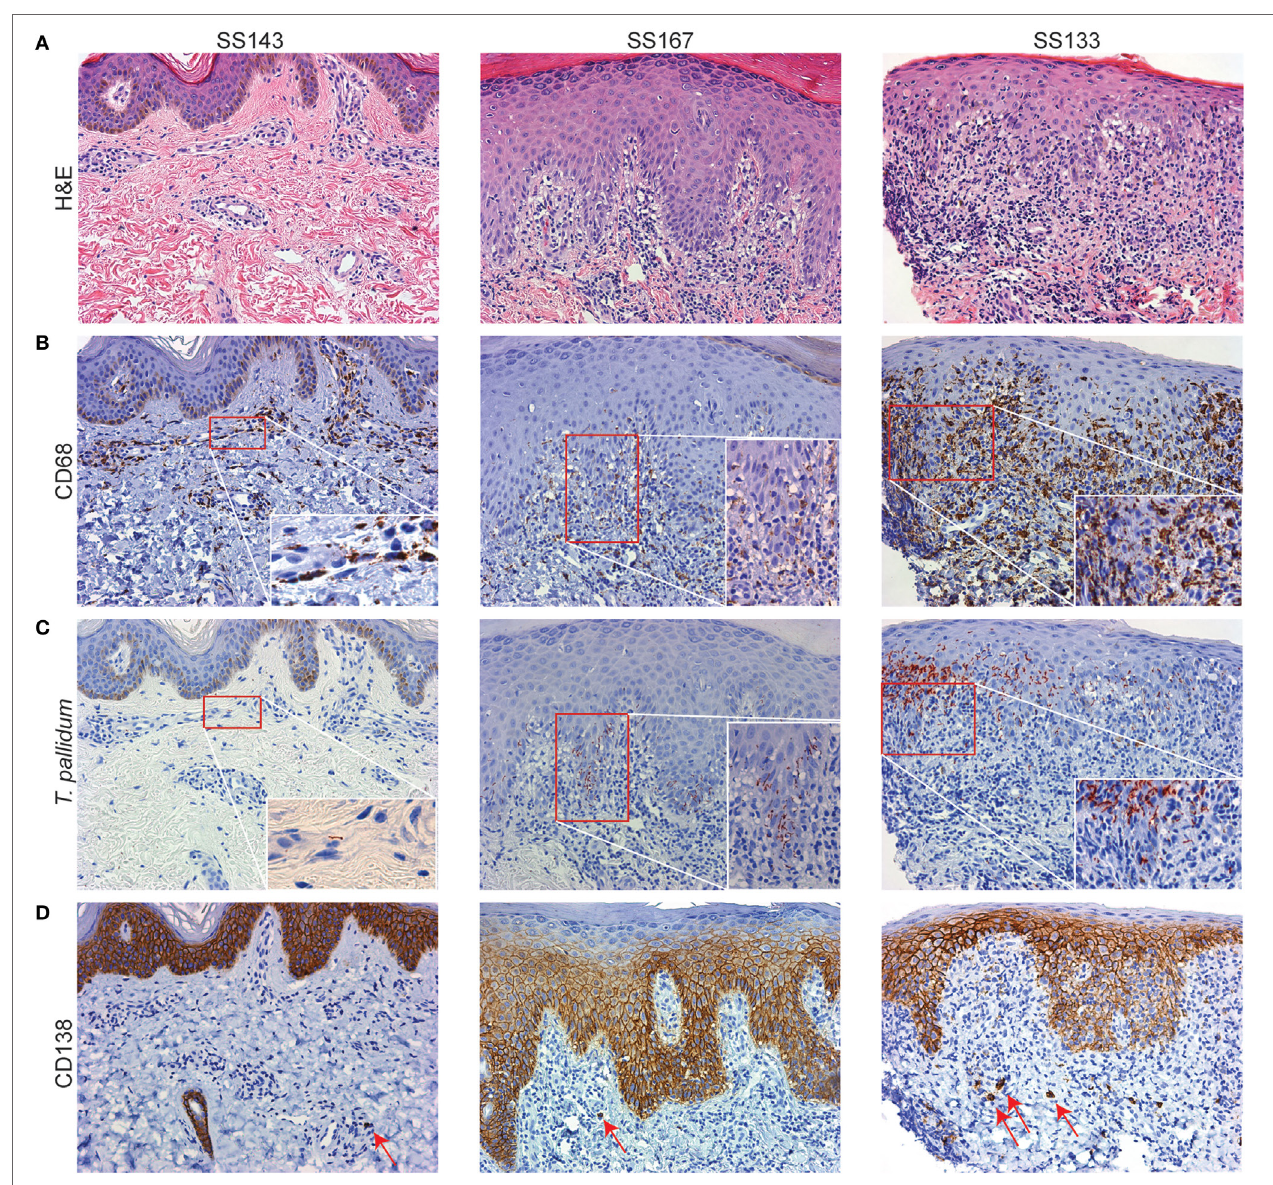
FigUre 1 | Secondary syphilis (SS) skin lesions are enriched with dermal macrophages. Representative skin biopsies obtained from three SS patients’ skin lesions were processed for hematoxylin and eosin (H&E) and immunohistochemical (IHC) analysis. (a) H&E-stained sections (10 × magnification) reveal an extensive dermal–epidermal lymphohistiocytic immune cell infiltrate with perivascular inflammatory changes. SS167 reveals mild psoriasiform hyperplasia with basal vacuolar changes. SS133 exhibits a classic lichenoid reaction pattern with basal vacuolation. (B–D) IHC testing of sequential tissue sections (B) varying numbers of CD68